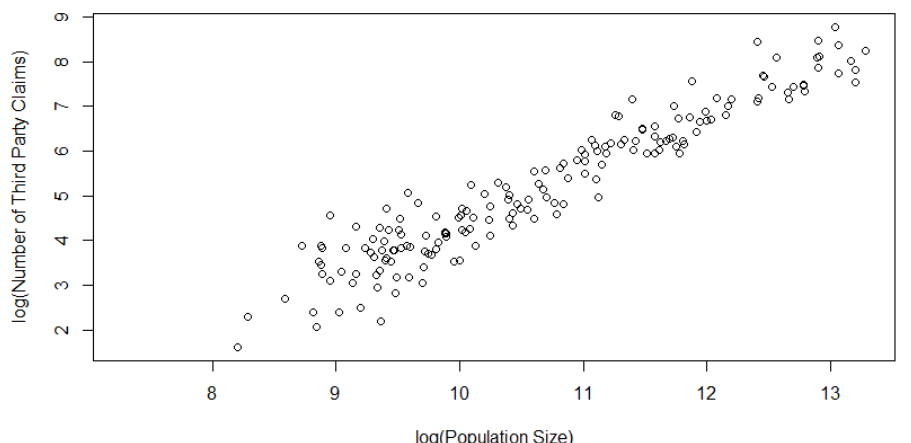
Figure 4. Scatterplot of the Model 2 data (on a natural log scale).